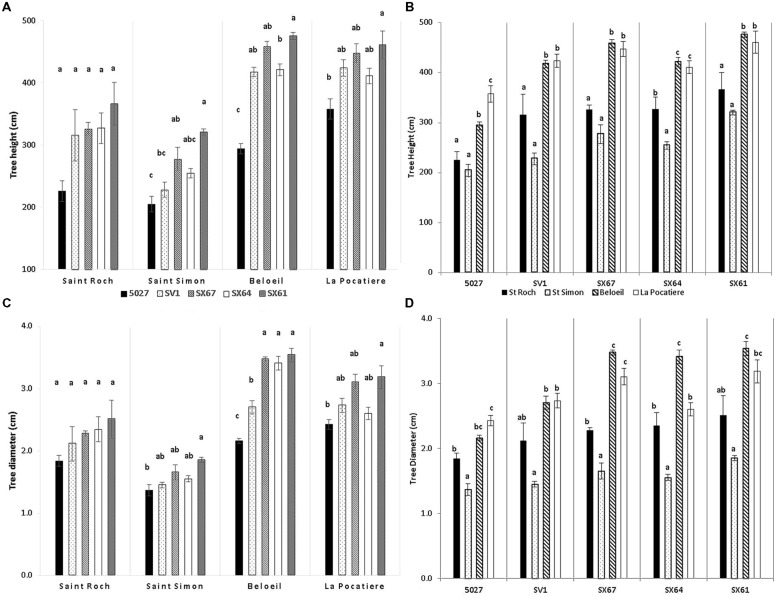
Tree height (A – by site; C – by genotype) and stem diameter (B – by site; D – by genotypes) from five willow cultivars in their second year of a harvest cycle (Salix viminalis 5027, S. dasyclados SV1, S. miyabeana SX61, S. miyabeana SX64, S. miyabeana SX67) sampled at four field trials in Québec: Saint-Roch-de-l′Achigan, Beloeil, S-S, and LP. Error bars represent standard error, n = 4 blocks (6 trees per block). Tukey′s Honestly Significant Difference (HSD) pairwise post hoc test (α = 0.05) are represented by letters a–c.